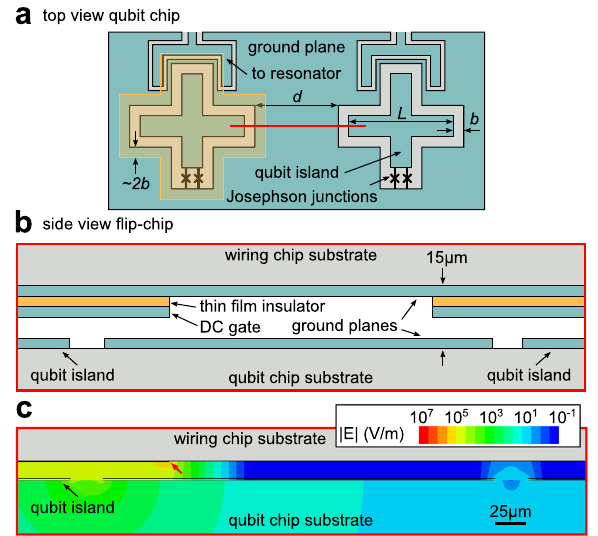
Fig. 4 Proposed integration in quantum processors. a Top view sketch of two Xmon-qubits. The orange region indicates the gate electrode above the left qubit. b Cross-section of the fl ip-chip stack, sketched along the red line shown in ( a ). The DC gate electrodes are separated by thin- fi lm insulators from the wiring chip ʼ s ground plane. c Simulated electric fi eld strength when 1 V is applied to the left gate electrode. The fi eld decays horizontally on a scale of about the distance between the qubit and the wiring chips (here, 15 μ m), resulting in small cross-talk below 10 − 4